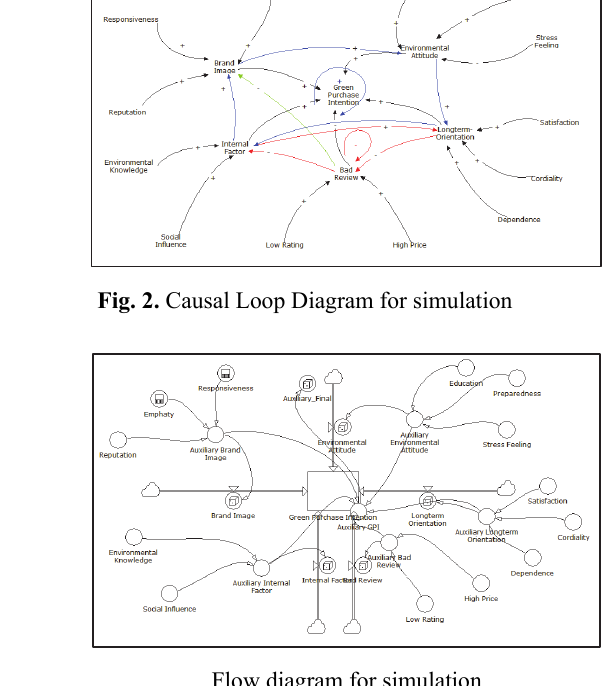
Flow diagram for